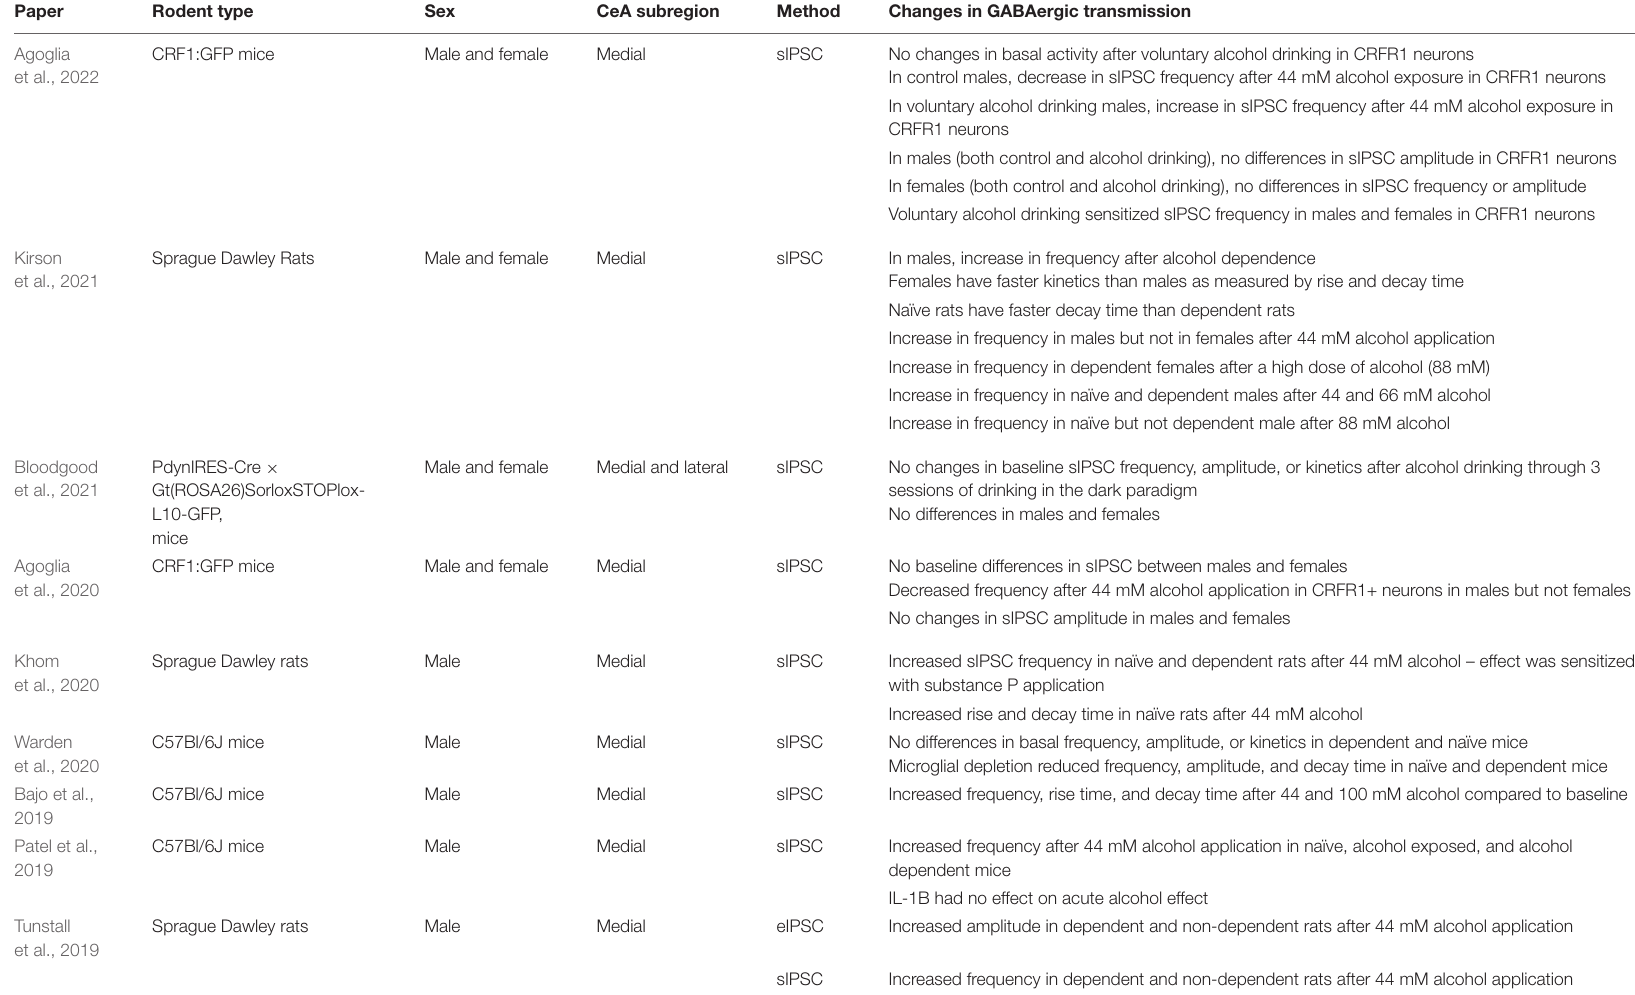
TABLE 1 | Summary of the data from multiple papers looking at GABAergic transmission in rats and mice through evoked (eIPSC), spontaneous (sIPSC), and mini (mIPSC) inhibitory postsynaptic currents (IPSC).